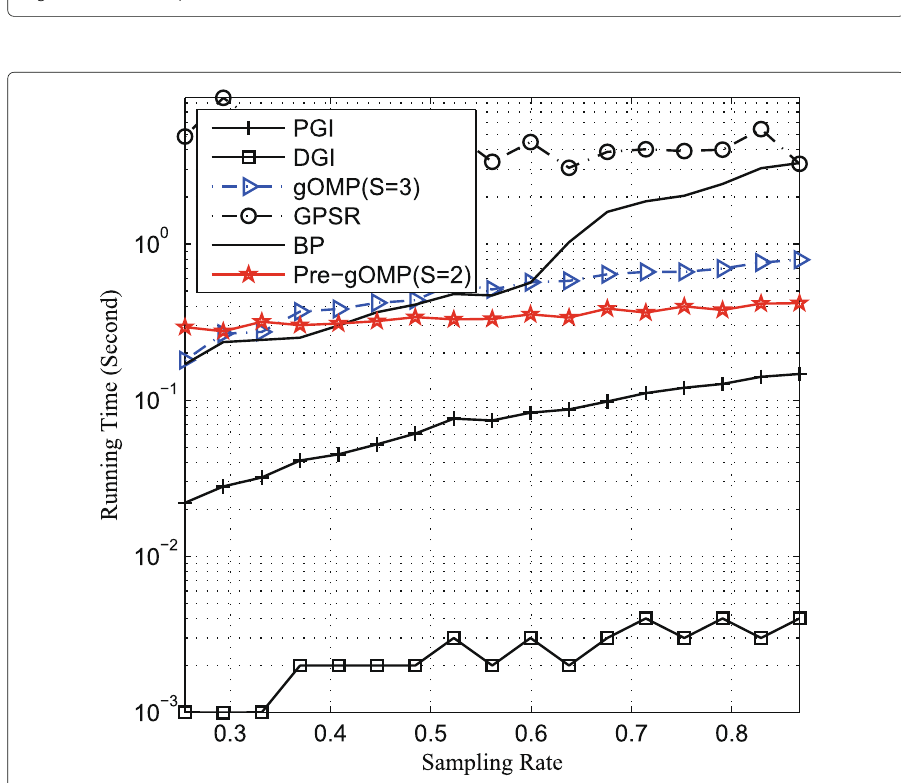
Fig. 6 Running time as a function of sampling rate. Different reconstruction algorithms are